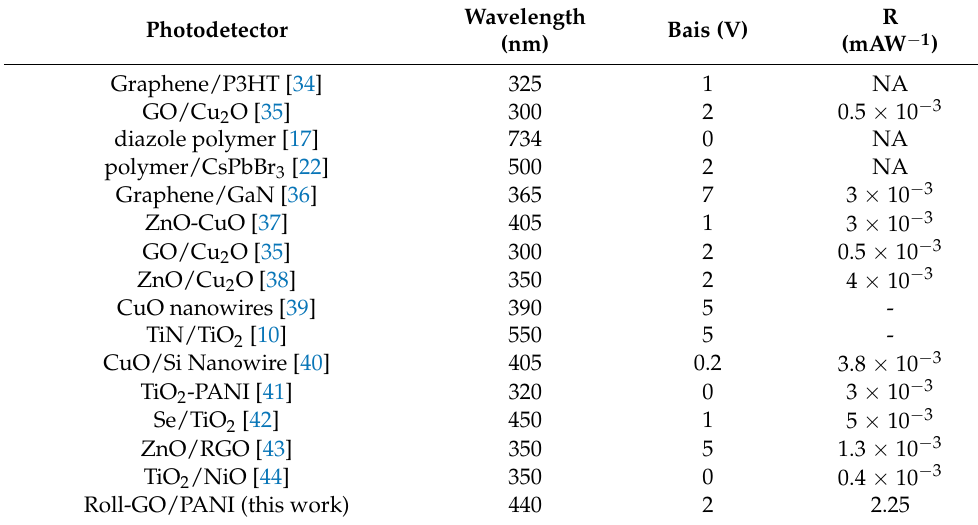
Table 1. The performance of the photodetector in comparison with published literature.